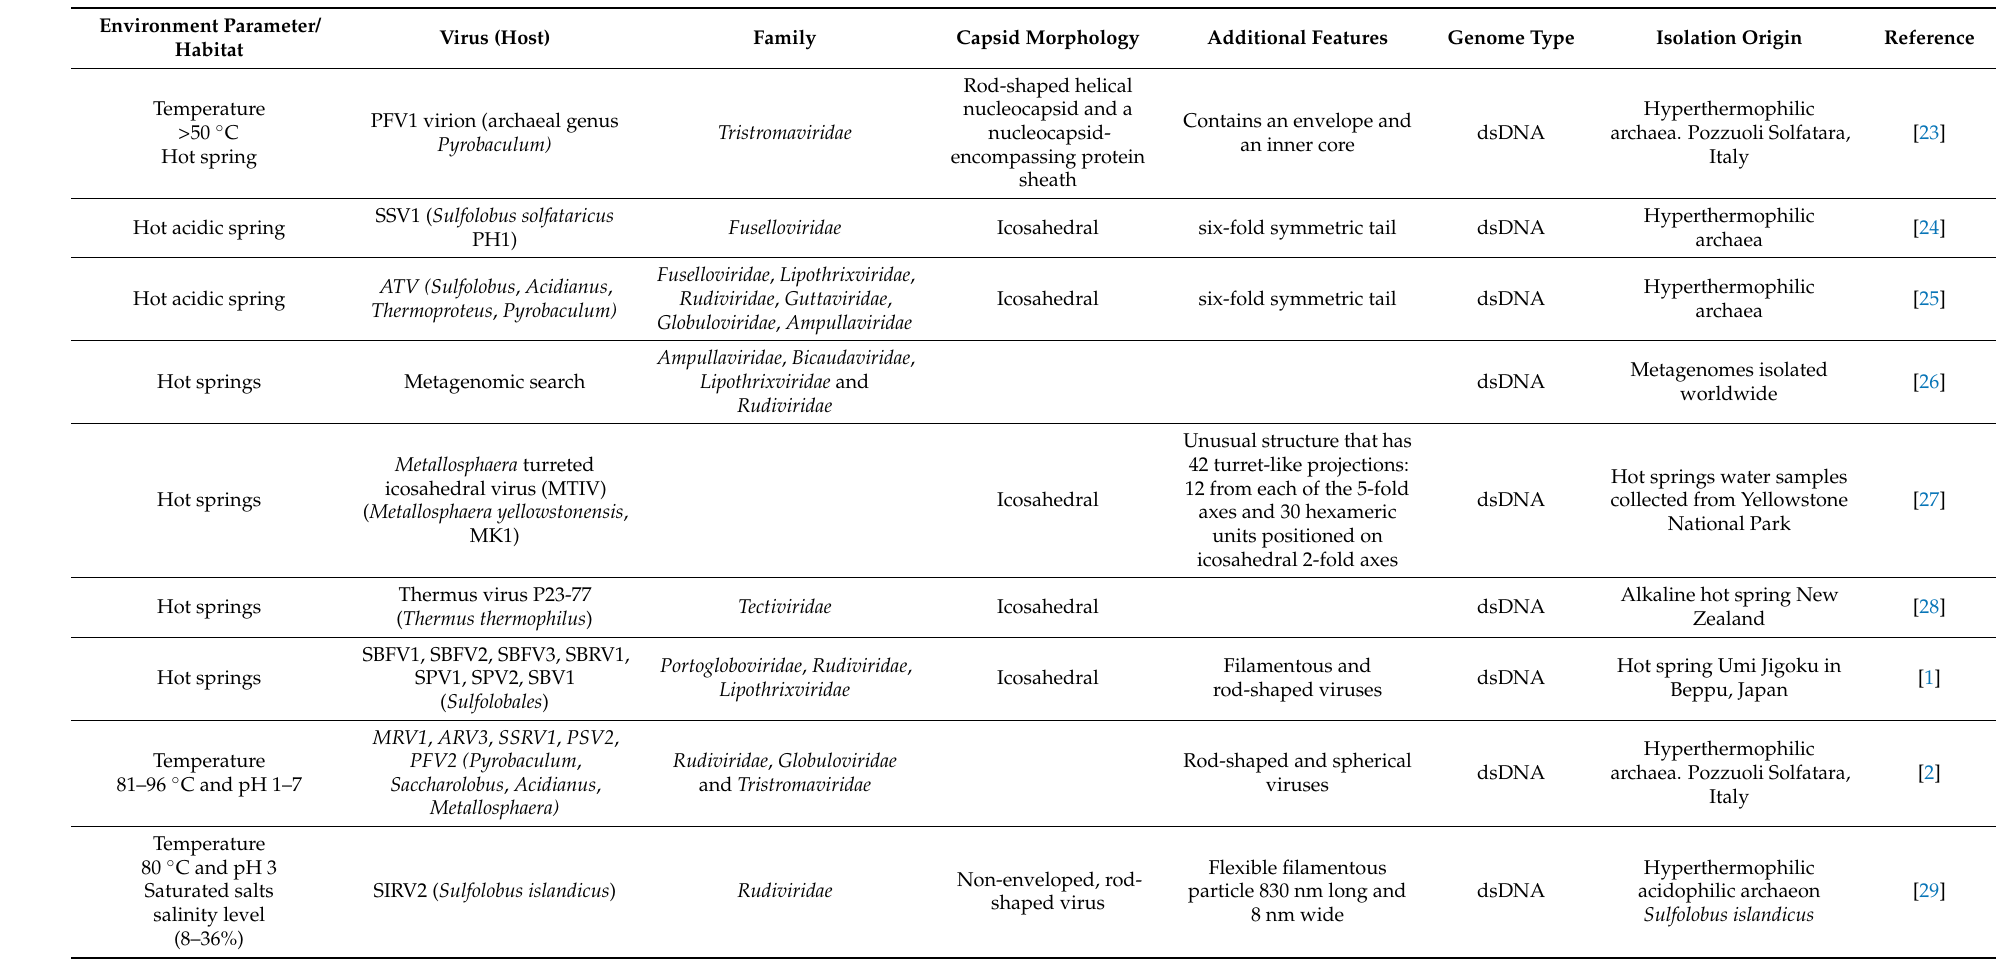
Table 1. Main features of the archaeal viruses characterized in extreme